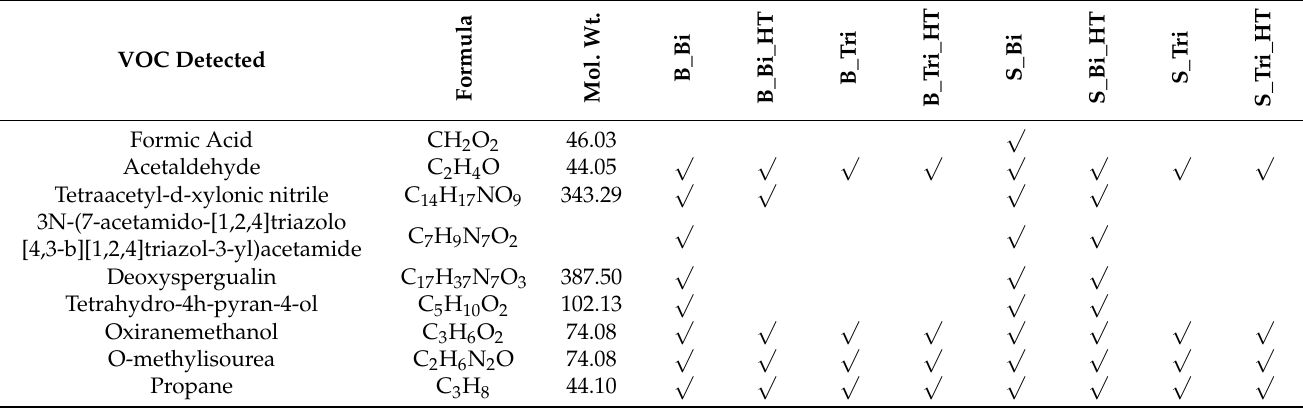
Table 9. Principal compounds detected by GC-MS of volatile organics from beech (B) and spruce (S) reactions involving bicine (Bi) and tricine (Tri). HT = thermal